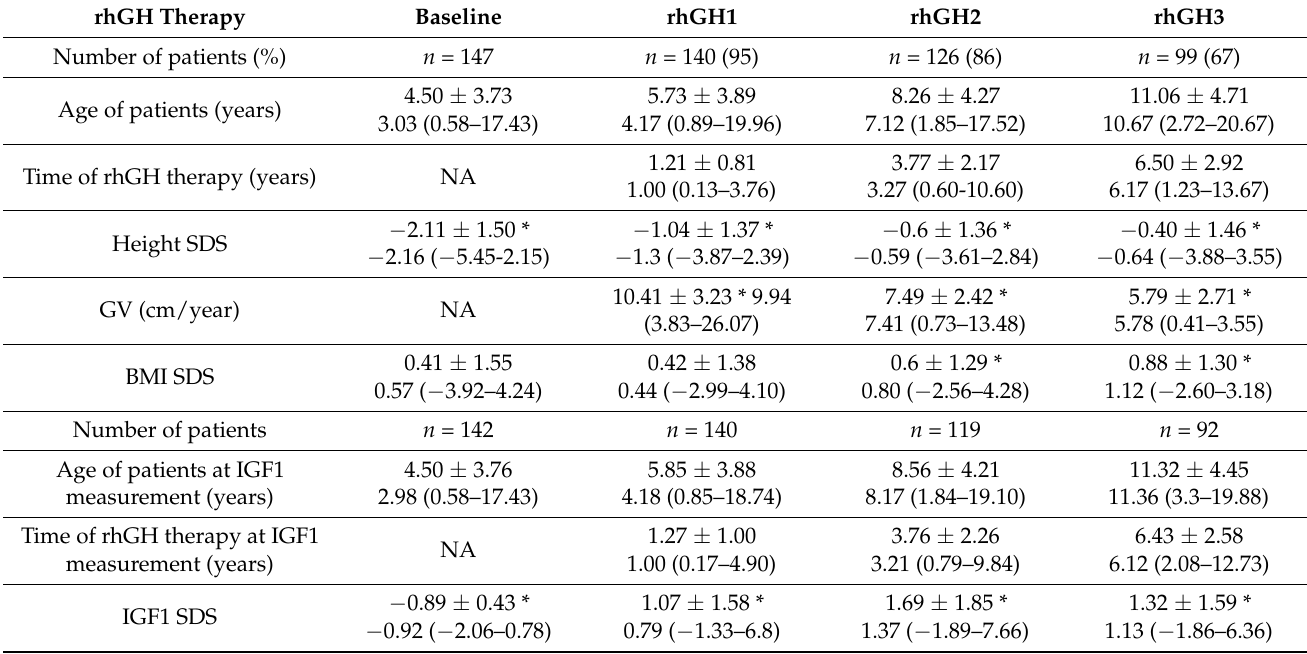
Table 2. Data during rhGH treatment in the whole cohort of patients with PWS, expressed as the mean value ± standard deviation scores (SDS) and median (minimal–maximal value).